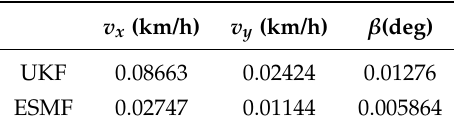
Table 2. RMSEs under the DLC